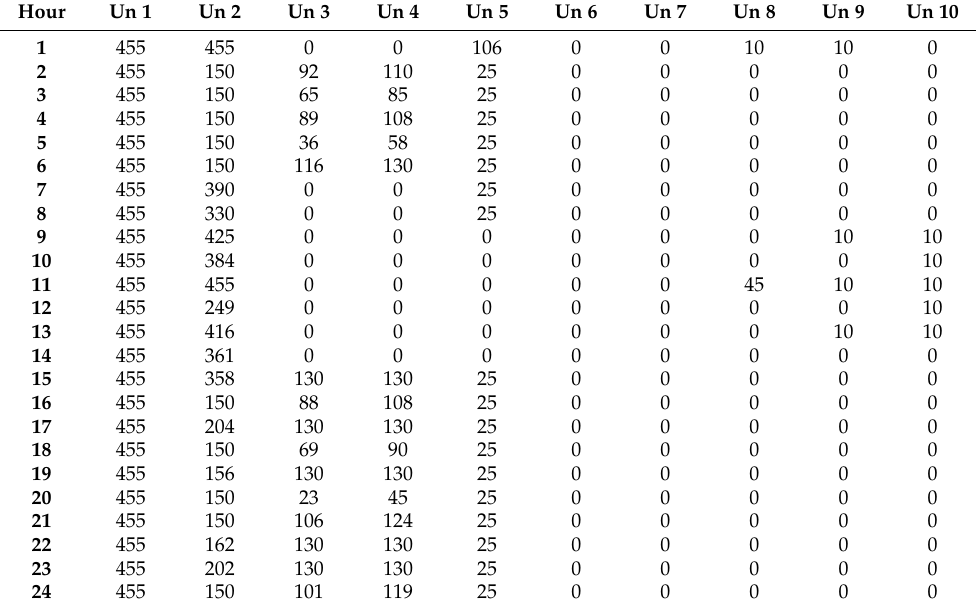
Table 12. Optimal output power for the 10-unit system over 24 h (test system